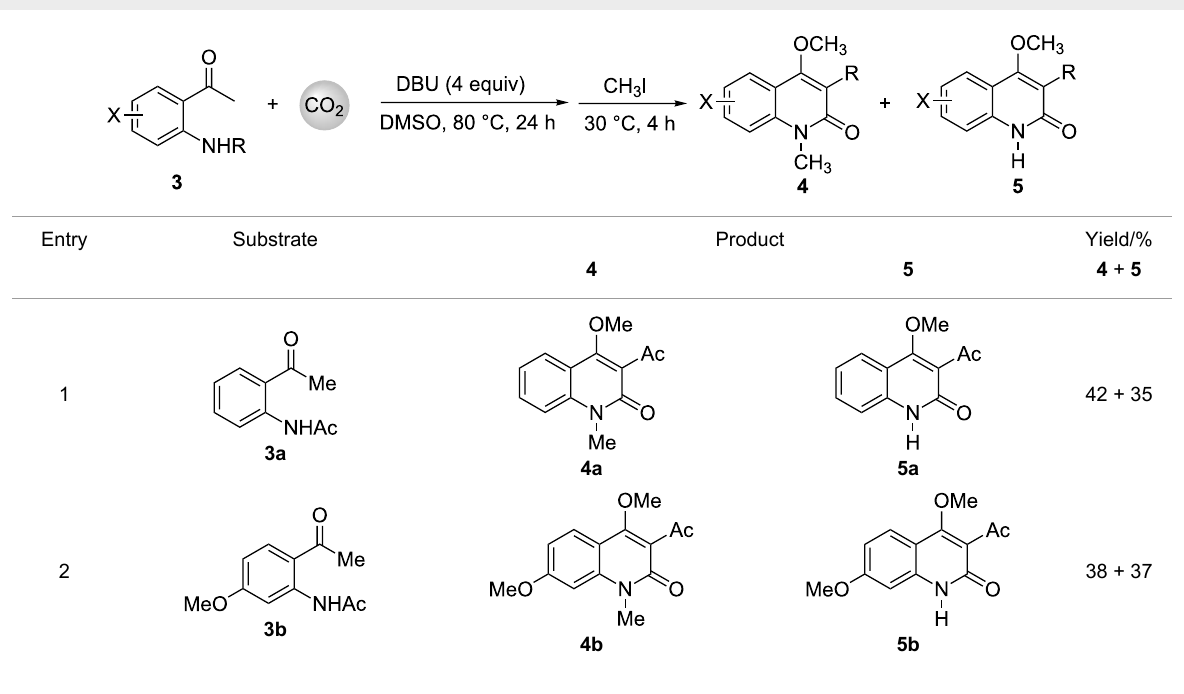
Table 3: Carboxylative cyclization of various o -acetamidoacetophenones with carbon dioxide. a